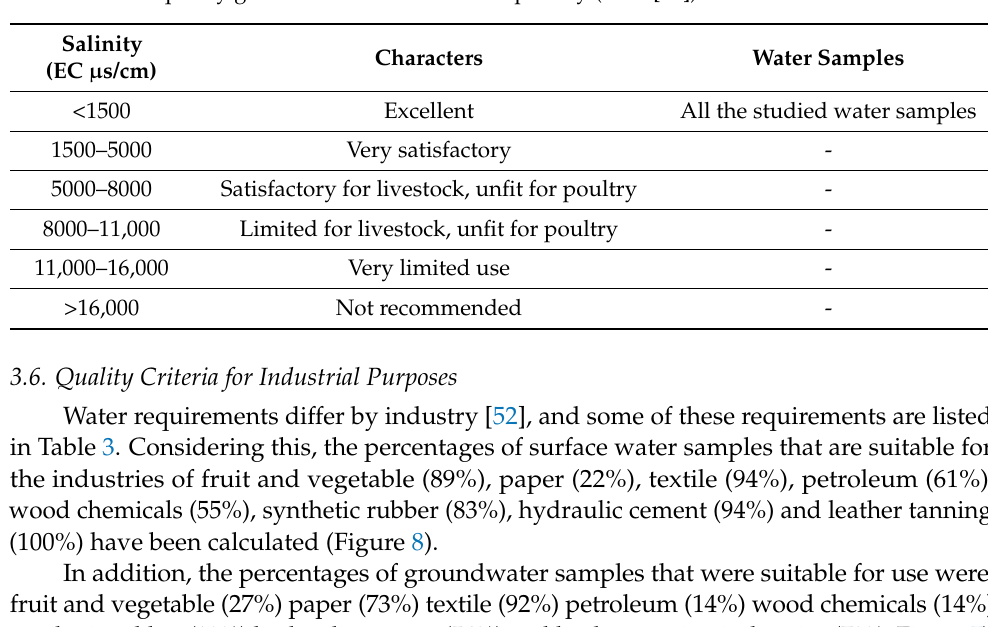
Table 2. Water quality guidelines for livestock and poultry (after [51]).